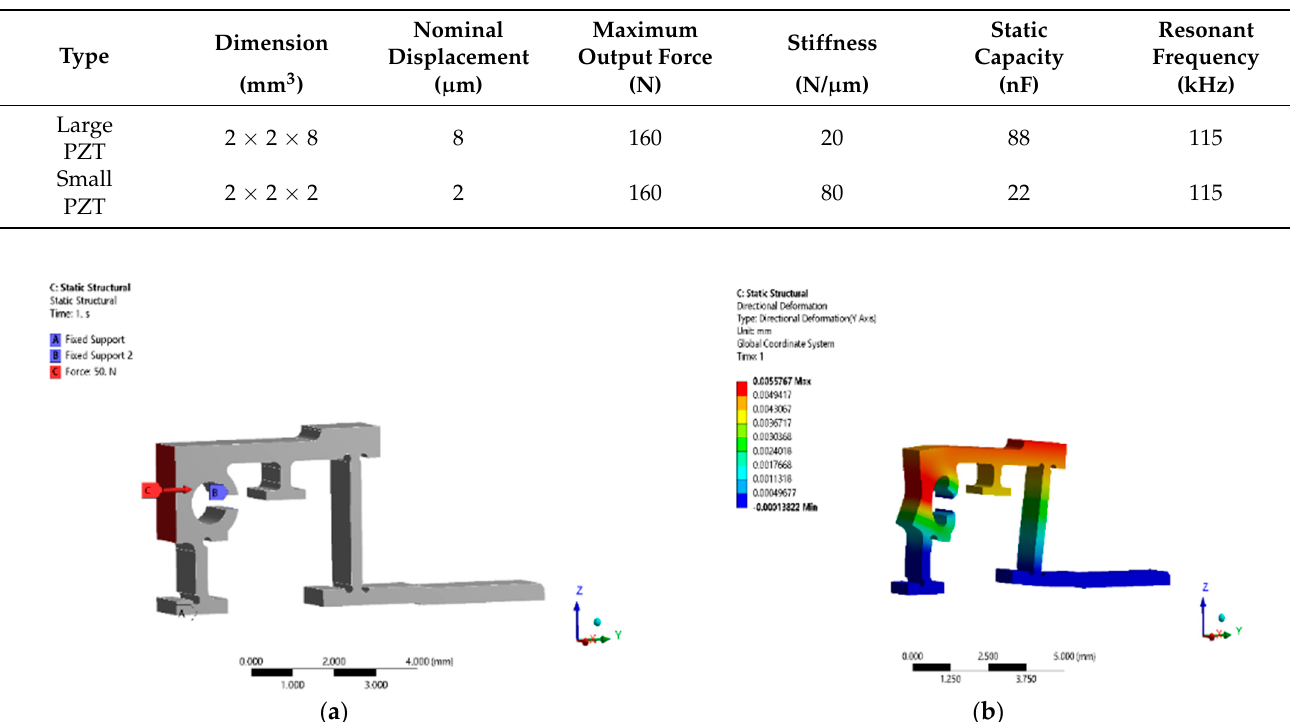
Table 1. Characteristic parameters of PZT.